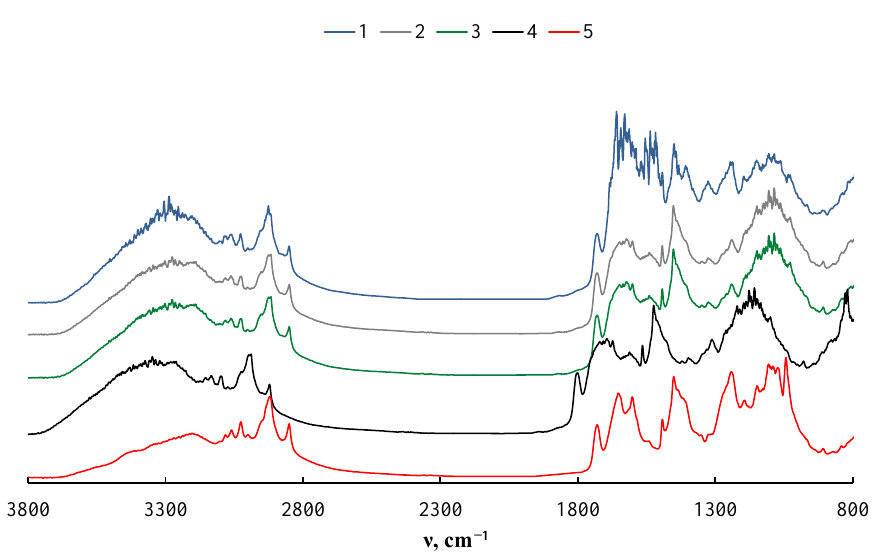
Figure 1. IR spectra of grafted copolymer obtained by polymerization of AA in the presence of TBB and collagen for 3.5 h at 60 (1), 45 (2), or 25 °C (3) and for collagen (4) and PAA (5).